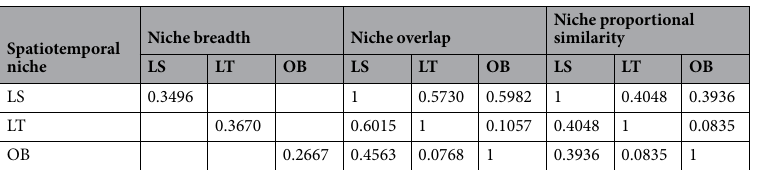
Table 1. Spatiotemporal niche of the two leafminer species, Liriomyza sativae (LS) and L. trifolii (LT) and the pupal parasitoid, Opius biroi (OB).